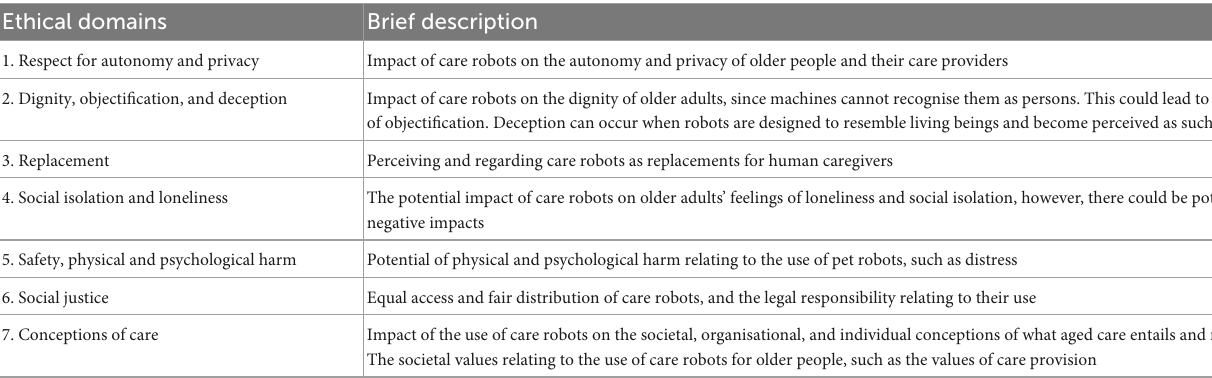
TABLE 1 Ethical domains relating to the use of care robots. Ethical